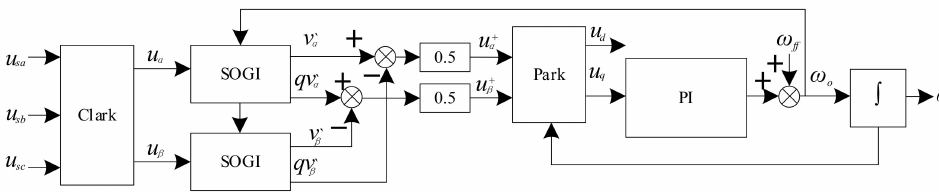
Figure 6. The grid voltage phase-locked unit.